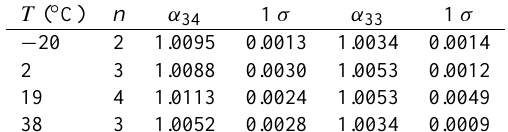
Table 4. Temperature dependent fractionation factors during the gas-phase oxidation of SO 2 by OH radicals.